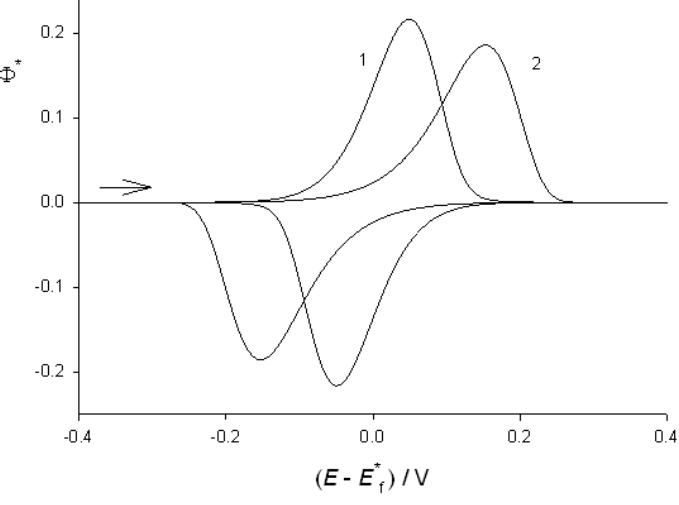
Fig. 4 Cyclic voltammograms of quasireversible reaction (1) (eq. 33). The transfer coefficient α = 0.5 and the dimensionless standard rate constant k ∗